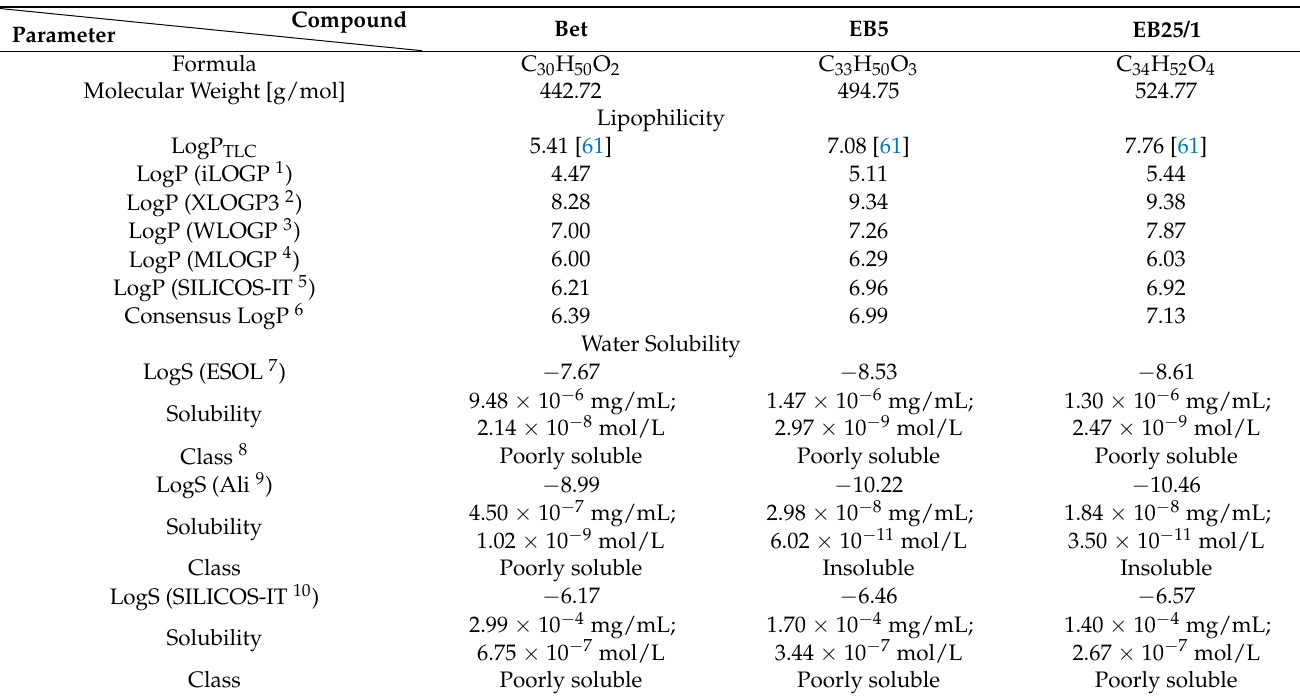
Table 2. Physicochemical parameters of Bet and ASBDs—comparison of values obtained both experimentally and in silico. Parameter